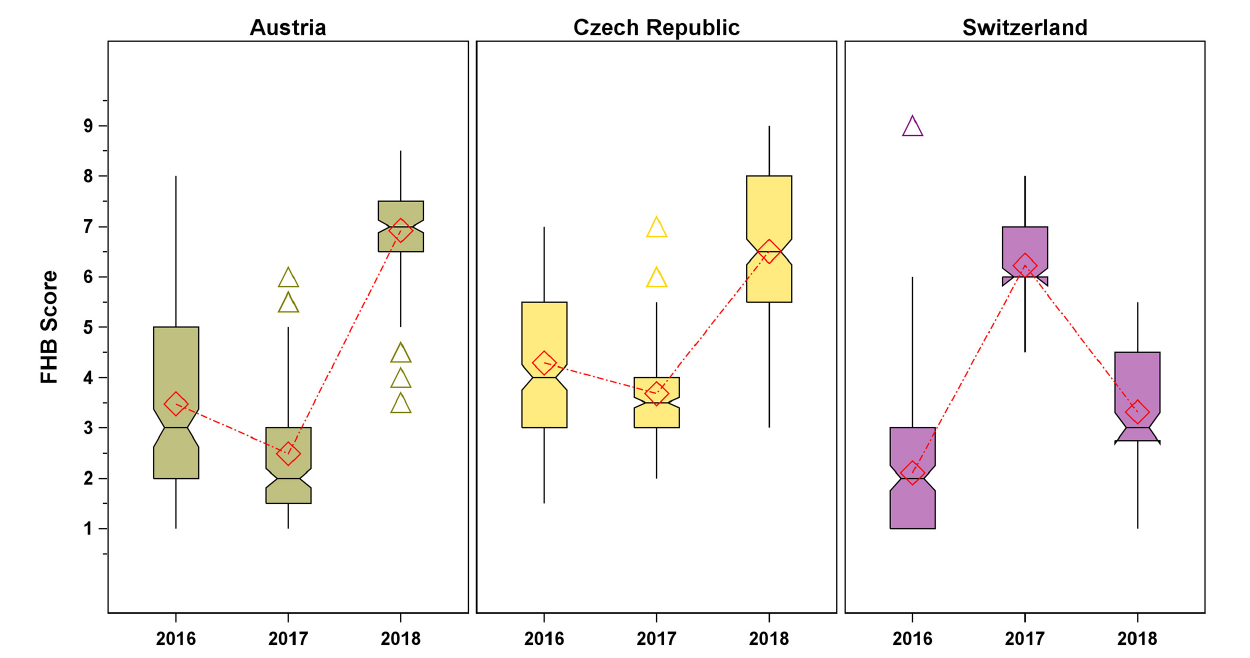
FIGURE 1 | Genotypic variation of spelt in the Fusarium head blight (FHB) score across the test environments. Diamond symbols connected by dash-dot lines represent mean values, the notches’ endpoints are located at ˜ x ± 1 . 58 × IQR √ , where ˜ x is the median, IQR is the interquartile range, and n is the group sample size. n The medians (central lines) of two box-and-whisker plots are significantly different at p ≤ 0.05 if the corresponding notches do not overlap. Whiskers are drawn to the lowest and largest values within the lower and upper fence (25th and 75th percentile + 1.5 × IQR ), respectively, triangles represent outliers.